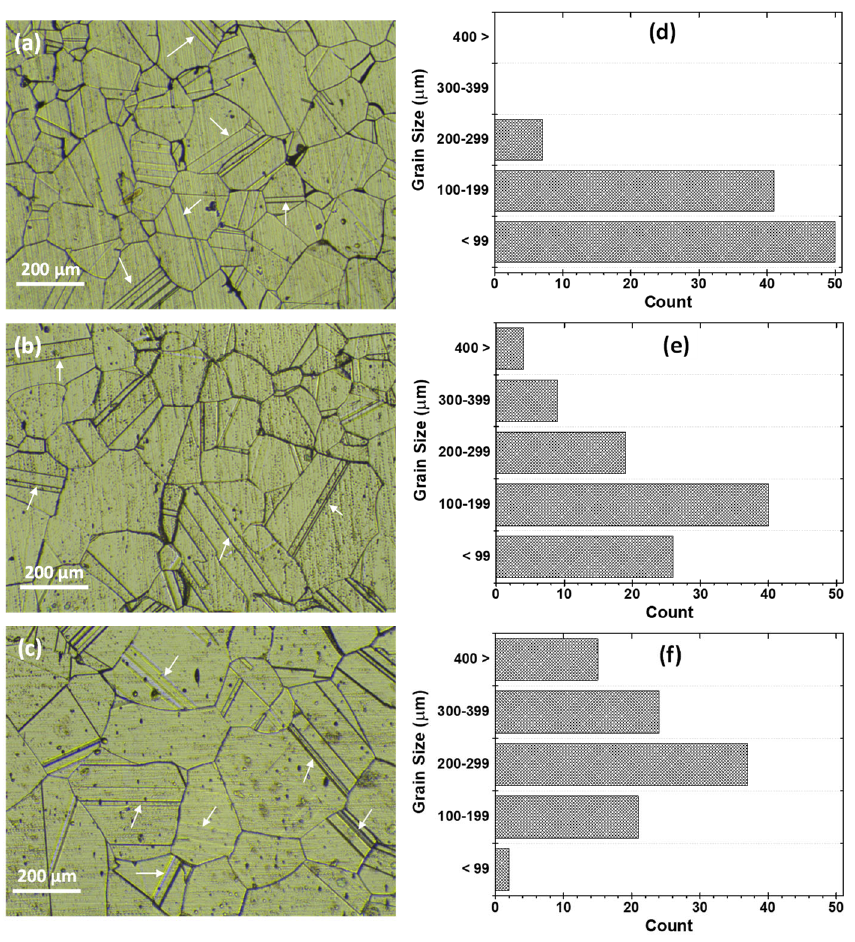
Figure 3. ( a – c ) Optical micrographs and ( d – f ) grain size distribution for heat-treated samples ( a , d ) T30, ( b , e ) T60, and ( c , f ) T120 .